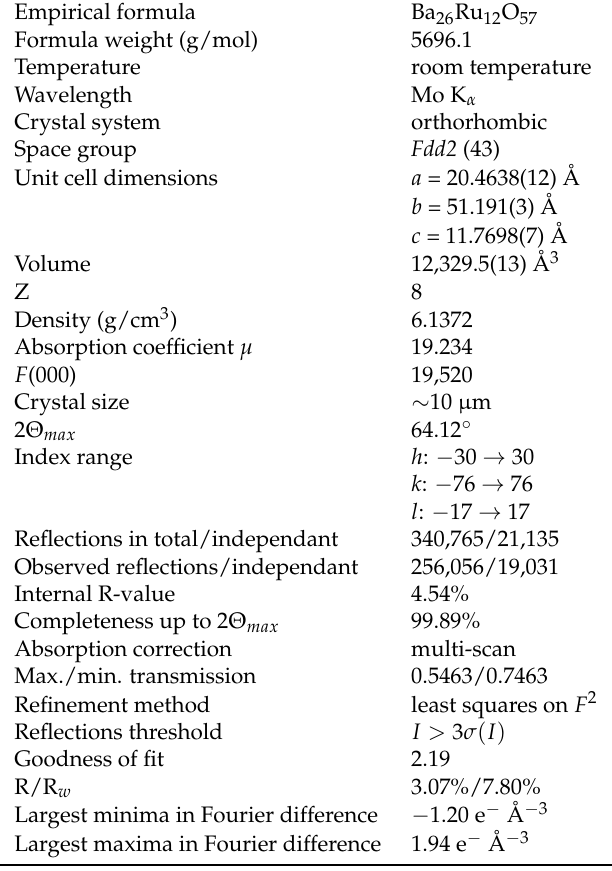
Table 1. Crystallographic & structural refinement data.